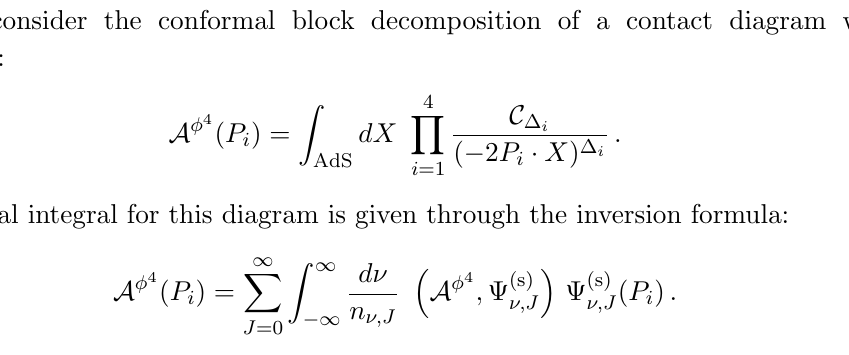
Figure 6 . The inner product